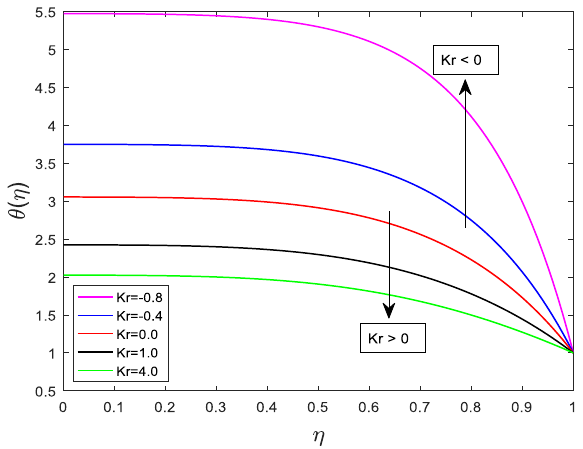
Figure 28: Effect of Kr on θ ( η ) for fixed S = Sc = 1.0, N b = 5.0, Ec = β = 0.5, Ha = N 2.0